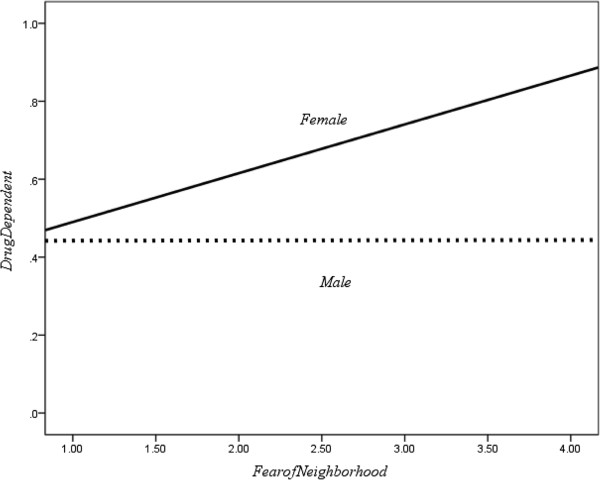
Moderator effect of gender to the drug dependence-fear of neighborhoodrelationship.